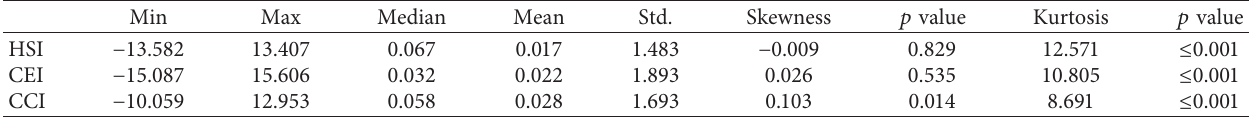
Table 1: Univariate descriptive statistics of returns.